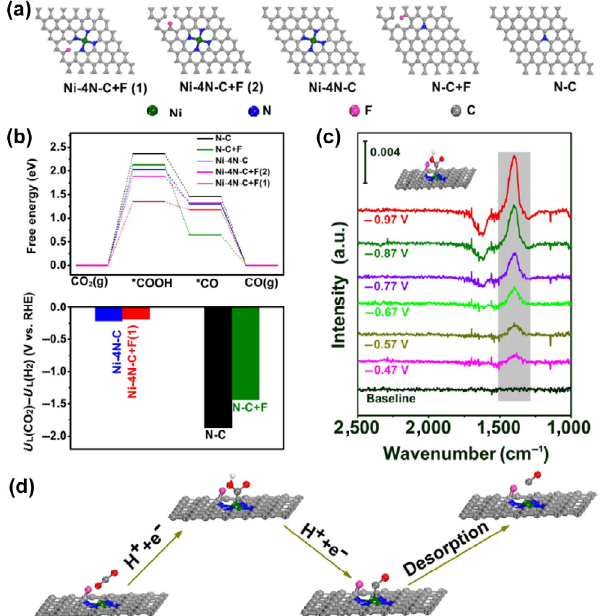
Figure 4 Evaluation of CO 2 RR performance of Ni-based catalysts. (a) Different model structures of the catalysts, (b) calculated Gibbs free energy diagrams for CO 2 -to-CO conversion on different catalysts, (c) the difference between the calculated limiting potentials for CO 2 reduction and H 2 evolution, (d) in situ ATR-IR spectra collected under different applied potentials in CO 2 -saturated 0.5M KHCO 3 and (e) the proposed reaction pathways of CO 2 RR over Ni-SAs@FNC. Reproduced permission from Ref. [91], © Elsevier B. V.